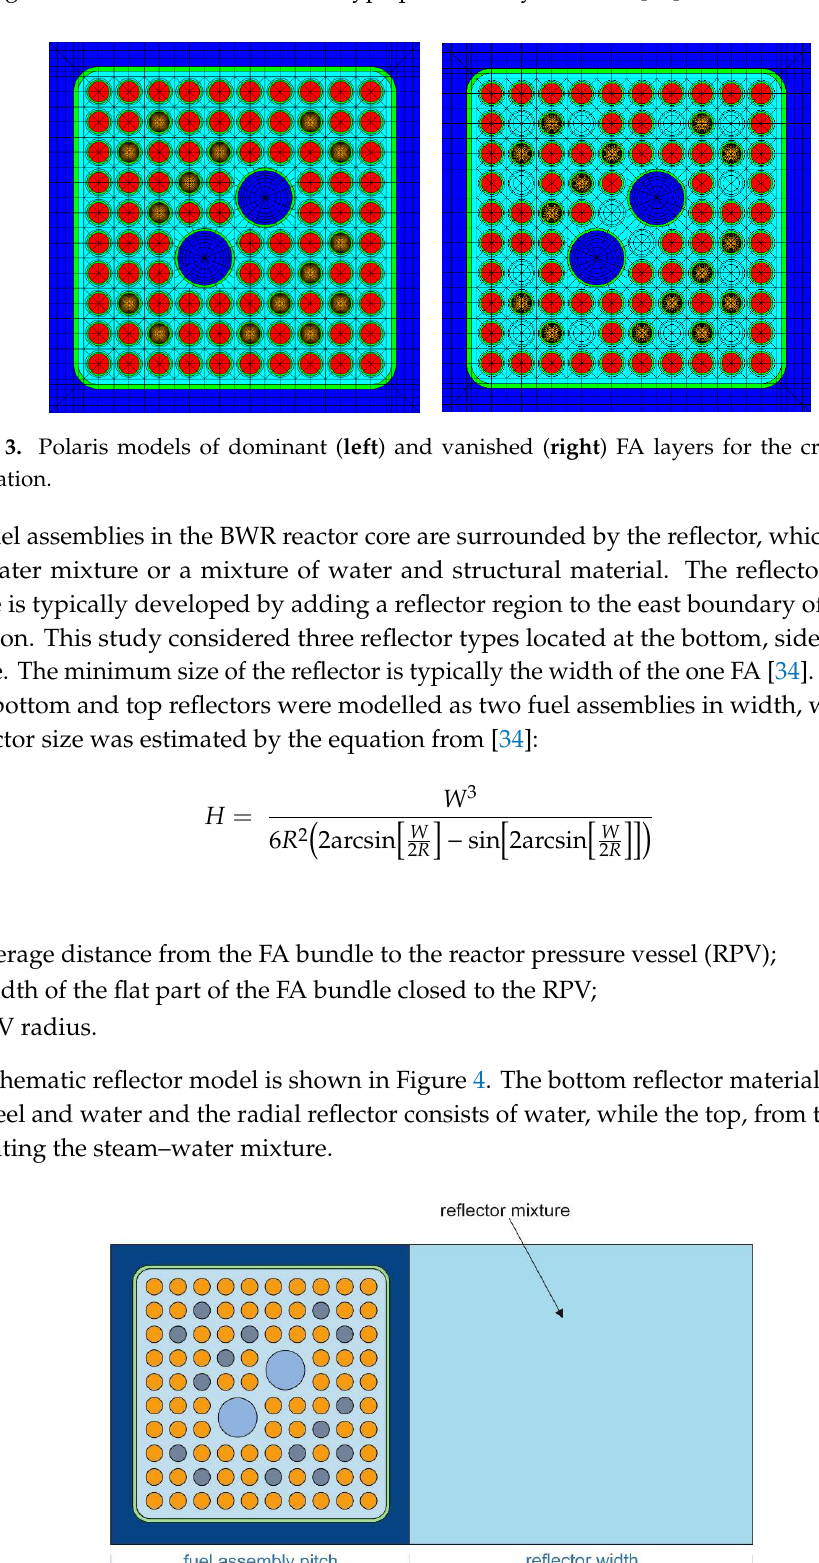
Figure 4. Reflector model for the cross-section preparation.